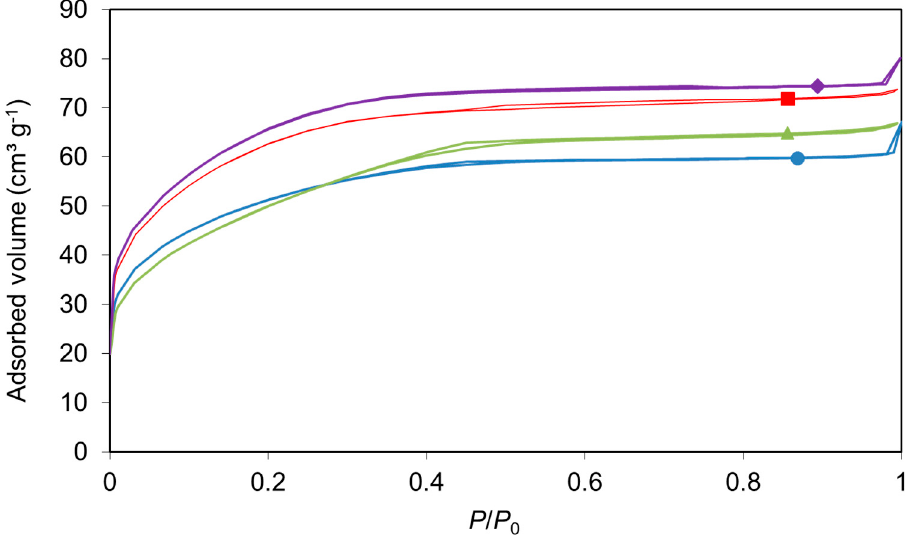
Figure 2. Nitrogen adsorption–desorption isotherms: ( ● ) pure TiO 2 , ( ▲ ) TiO 2 /Fe0.5, ( ■ ) TiO 2 /N43 and ( ♦ ) TiO 2 /Fe0.5/N43.